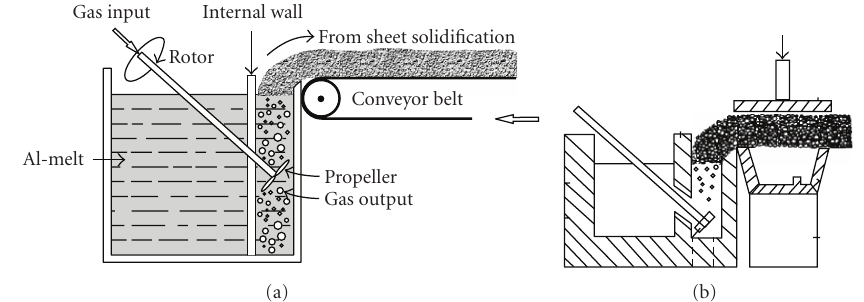
Figure 1: Apparatus for MGI [2–6].